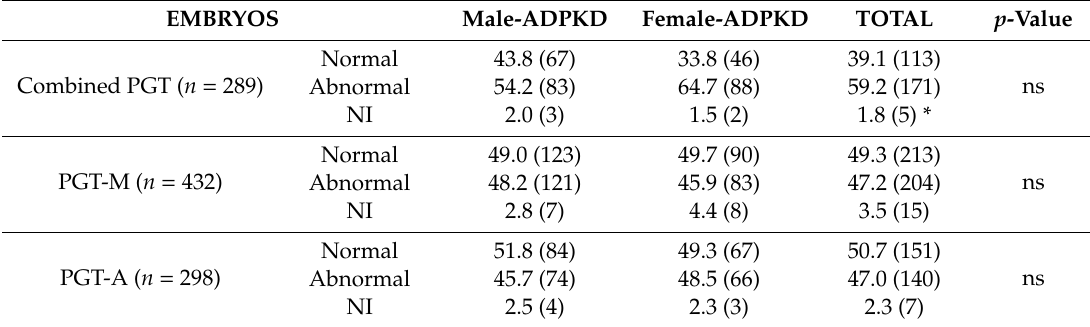
Table 2. Results per embryo presented by male-ADPKD and female-ADPKD cycles (% (n)). EMBRYOS Male-ADPKD